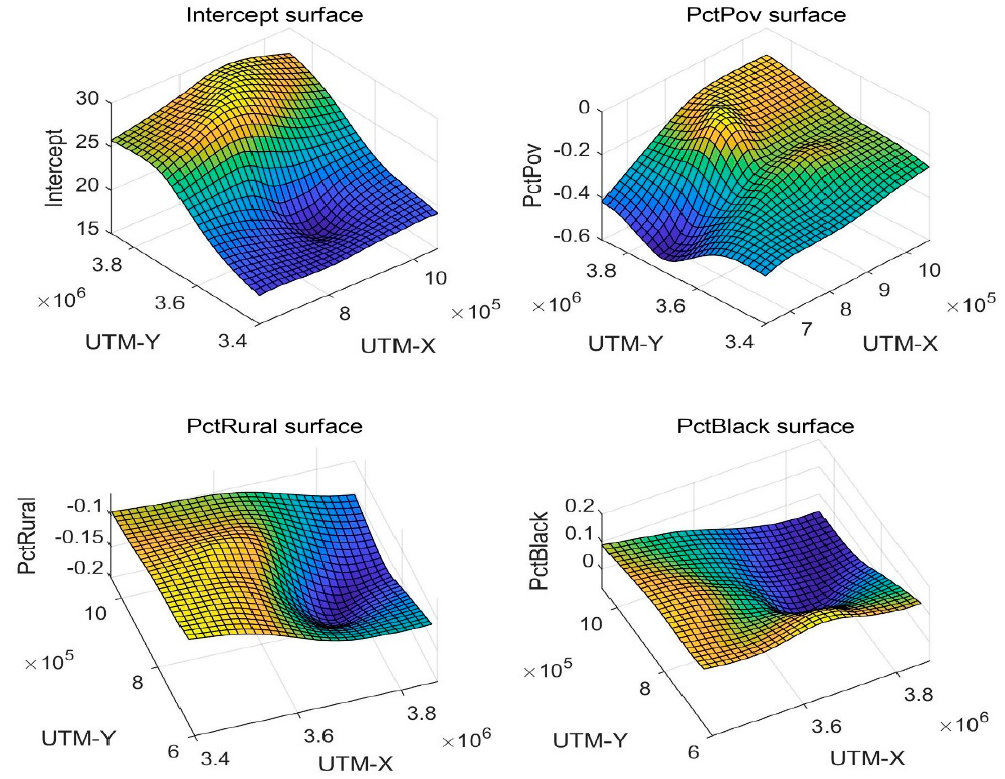
Figure 7. Surfaces of coefficient estimates.